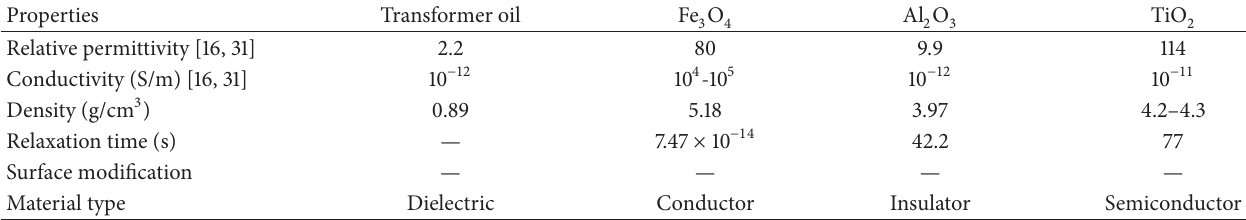
Table 1: Basic properties of chosen nanoparticles.